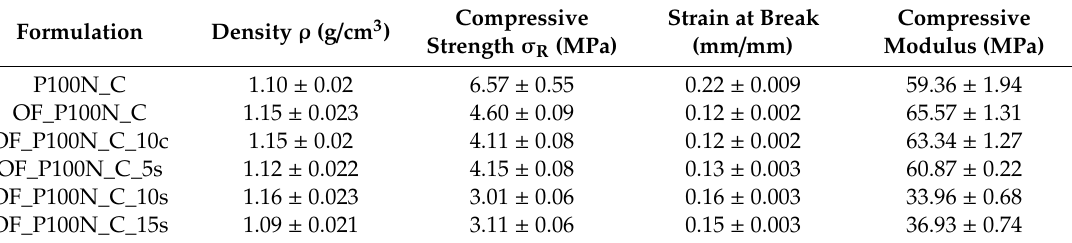
Table 2. Mechanical properties of the samples with and without additives.